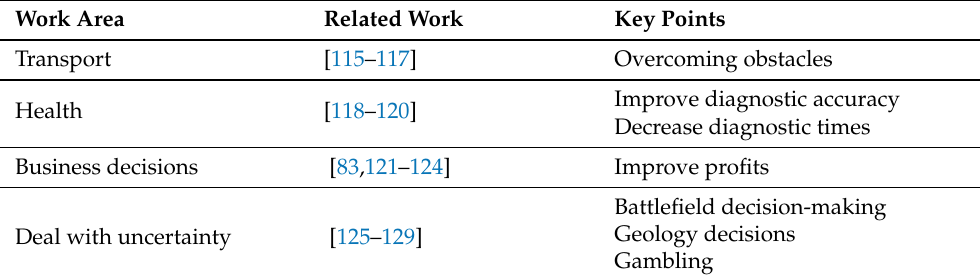
Table 5. Works supported by unsupervised